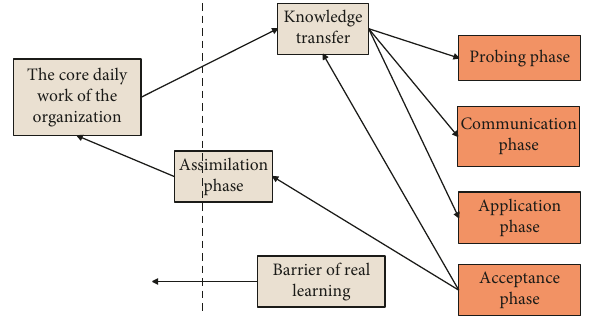
Figure 6: Five-stage